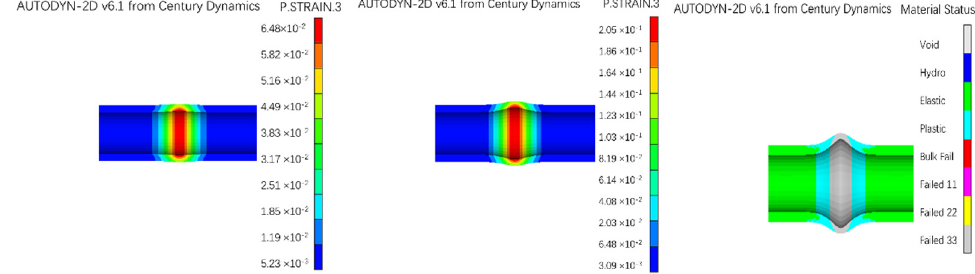
Figure 6. Circumferential strain cloud of 8 mm-thick shell at 16, 29 and 41.6 g TNT.